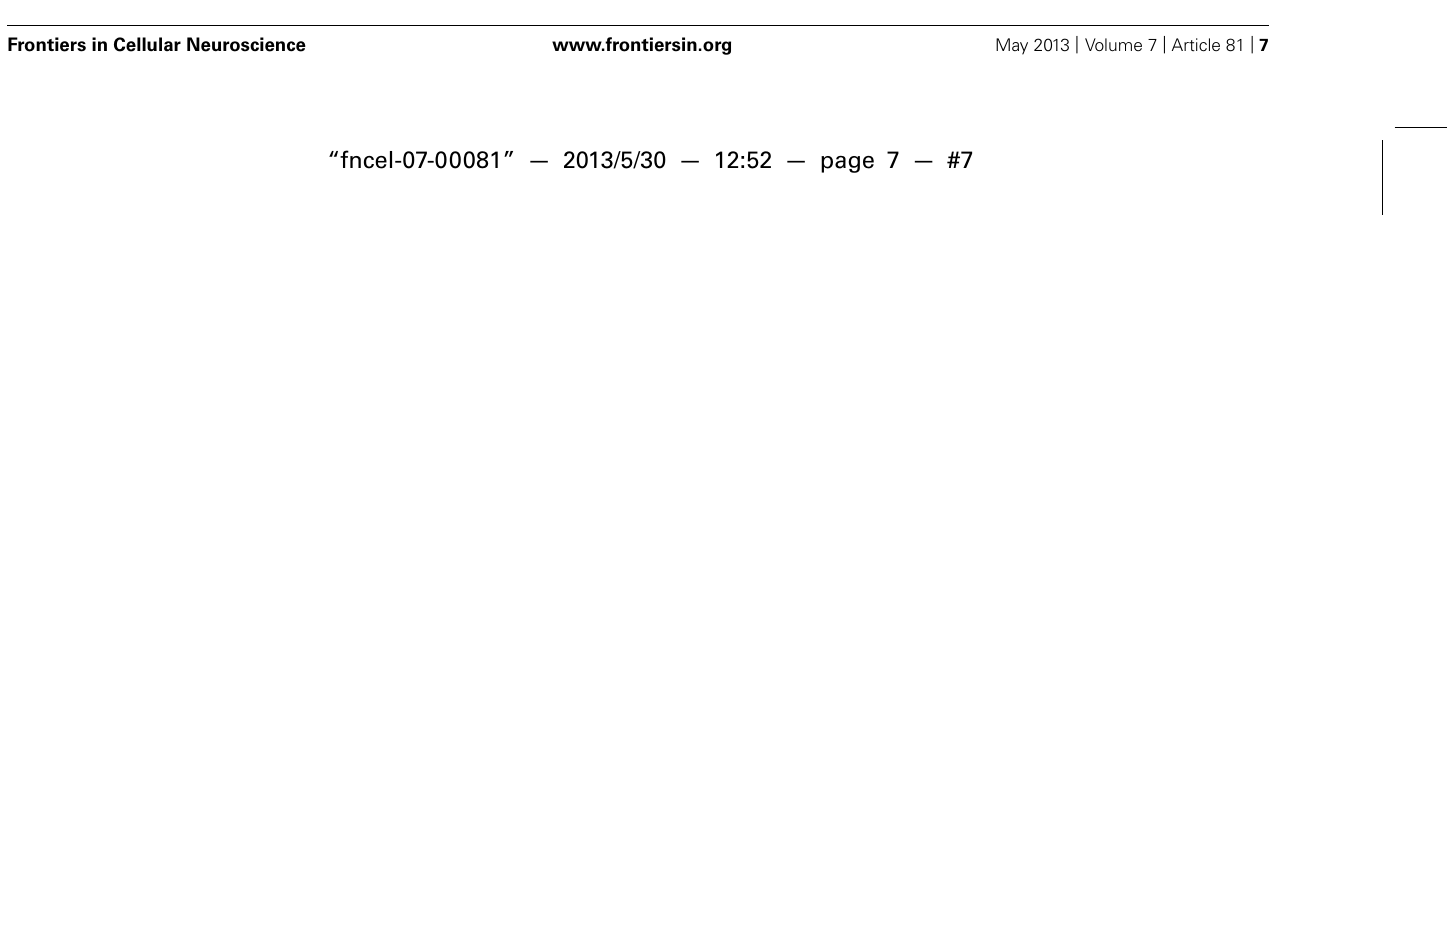
FIGURE 5 | Induced α -synuclein expression increases the sensitivity of cells toAA-elicited cytotoxicity. Five sets of differentiated 3D5/DAT cells with 0, 2, 4, 6, and 8 days of induced α -syn expression were exposed to AA for 60 h and referred to as IN0d/AA, IN2d/AA, IN4d/AA, IN6d/AA, and IN8d/AA, respectively. (A) Western blotting of lysates derived from these cells with antibodies to α -syn, active caspase 3 as well as GAPDH showed a time-dependent increase of monomeric and oligomeric α -syn species as well as that of active form of caspase 3. (B–D) Bar graphs summarized quantitative analysis of α -syn and active capase 3 immunoreactivities displayed in (A) and normalized with GAPDH as well in western blot from